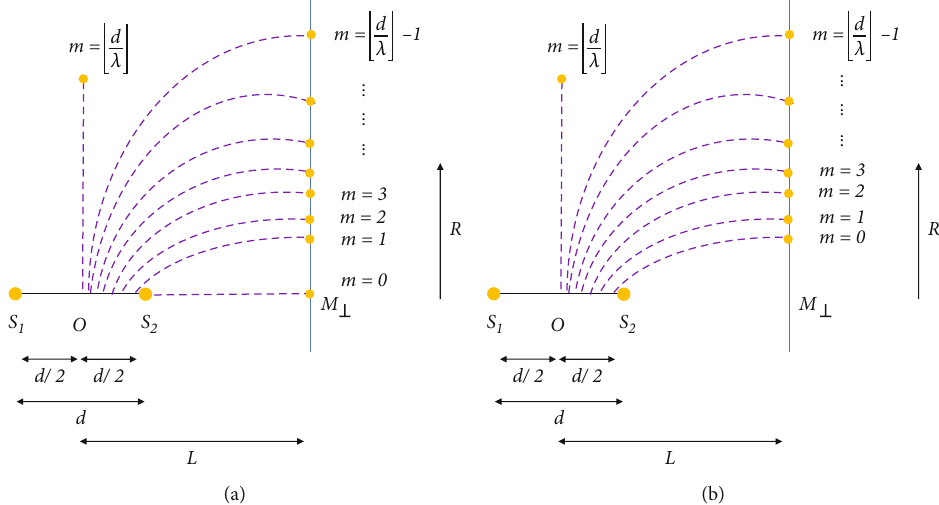
Figure 6: Circular shaped fringes (yellow dots) distributed on a distant screen (blue line) oriented perpendicular to the line S when d / λ ∈ ℕ (a) and d / λ ∉ ℕ (b). f L , m , R g denotes distance between the midpoint O of S 1 S 2 and the screen midpoint M ⟂ , circular fringe order, and radius, respectively. Family of hyperbolas with point sources S 1 and S 2 as common foci (purple) (reproduced from [27] ©IOP Publishing Ltd. CCBY